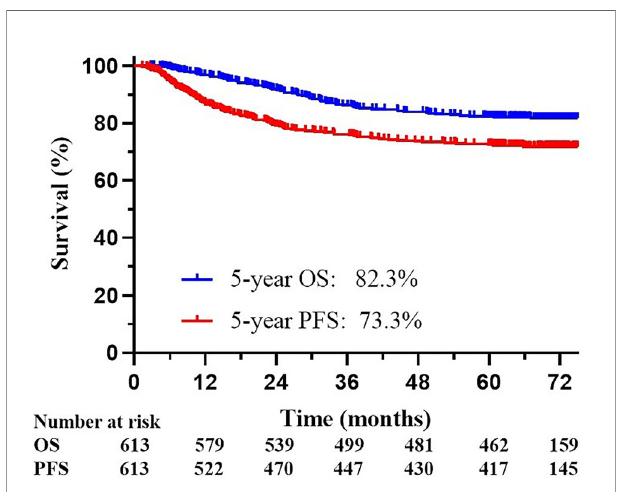
FIGURE 1 | Kaplan-Meier overall survival (OS) curve and progression-free survival (PFS) curve for all 613 patients included in the analyses.